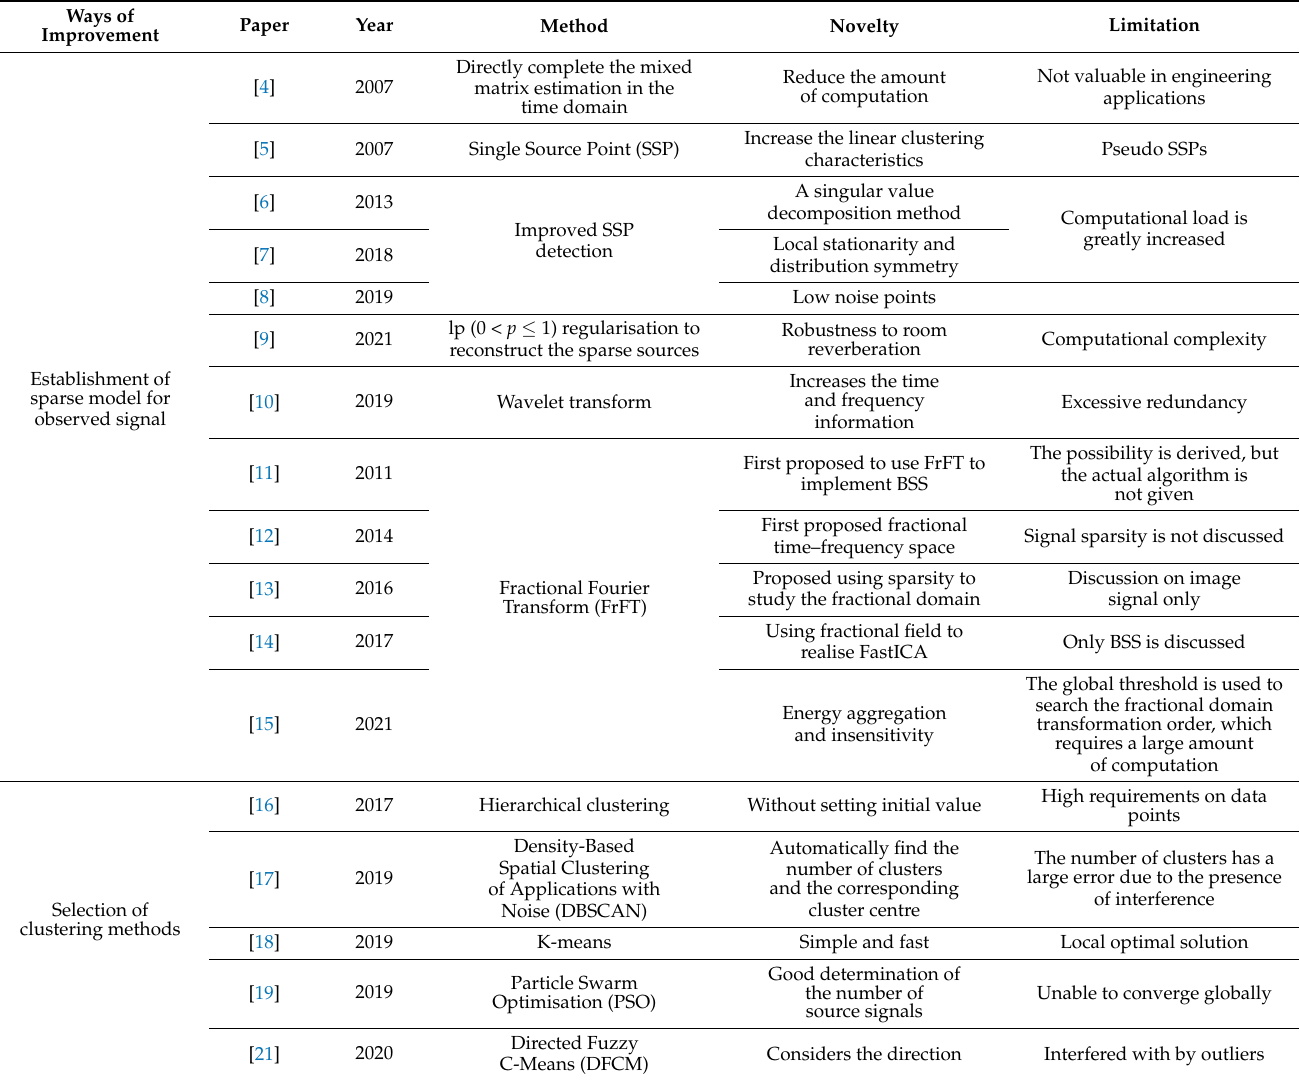
Table 1. Research summary of the mixing matrix in recent